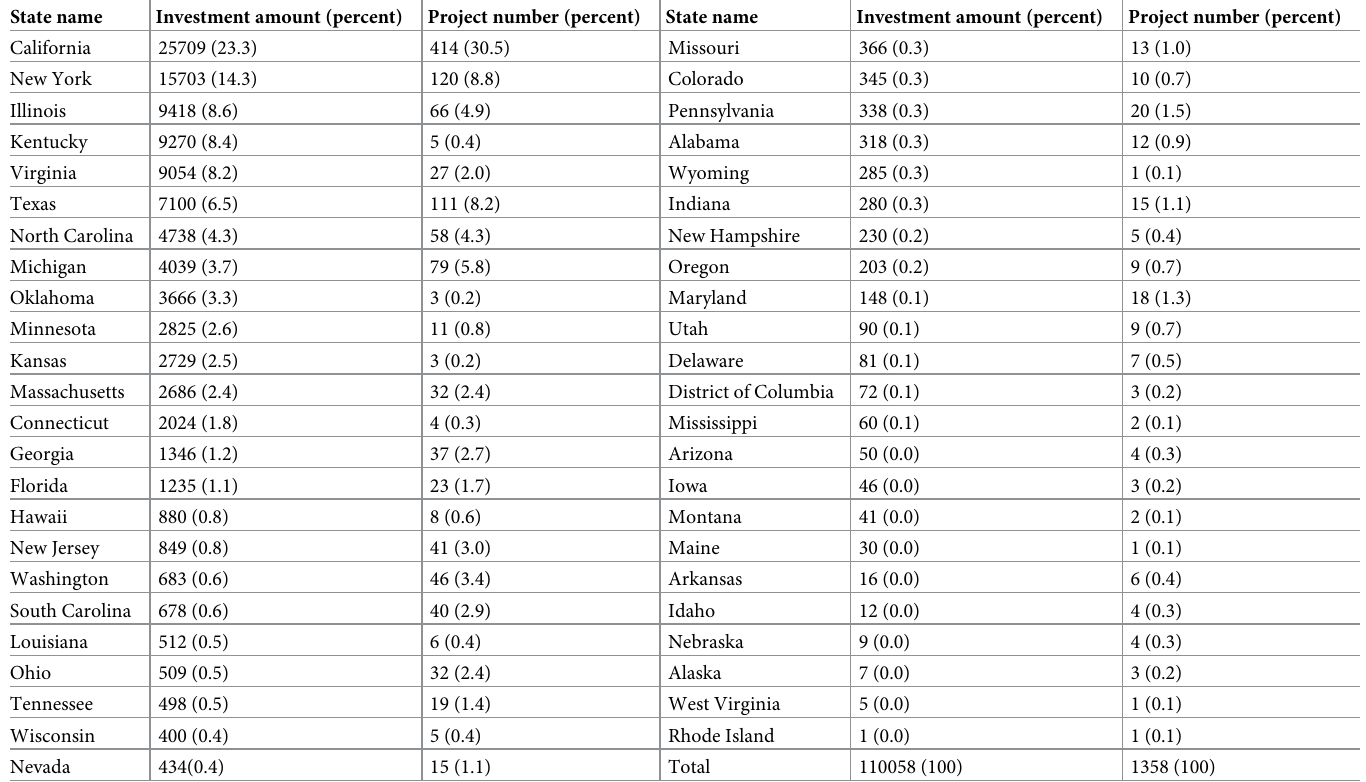
Table 1. Distribution of CODI over the states of the United States,